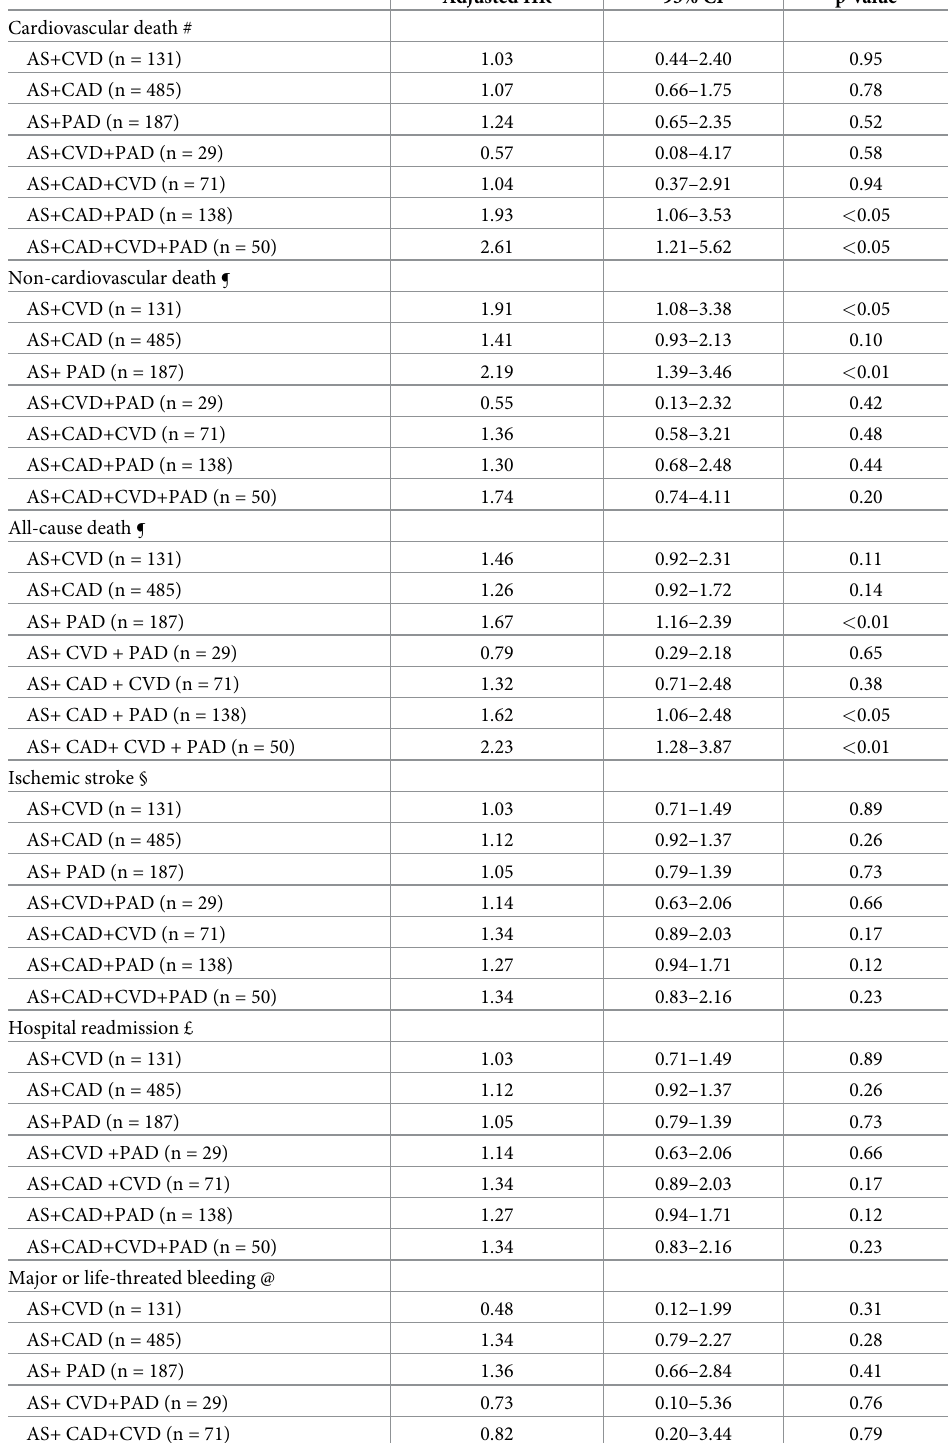
Table 4. Adjusted risk for the 2-year clinical outcomes of patients with AS in addition to CVD, CAD, PAD, CVD +PAD, CAD+CVD, CAD+PAD, and CAD+CVD+PAD undergoing TAVI compared with patients with AS